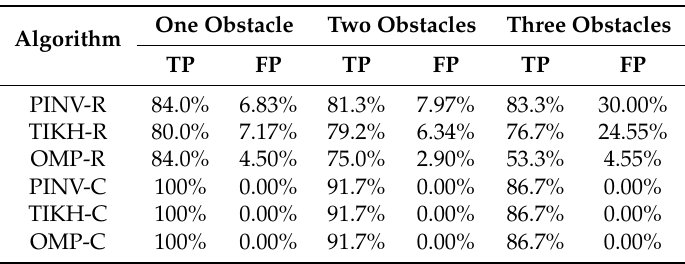
Table 2. Percentage of true positives and false positives regarding detected obstacles.